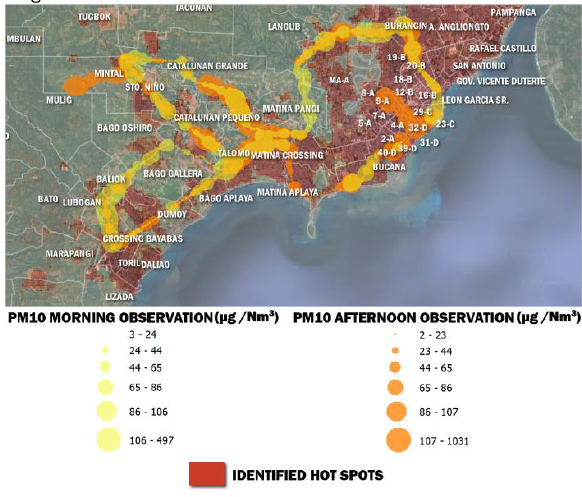
Figure 1. Track of Particulate Matter 10 traverse survey.